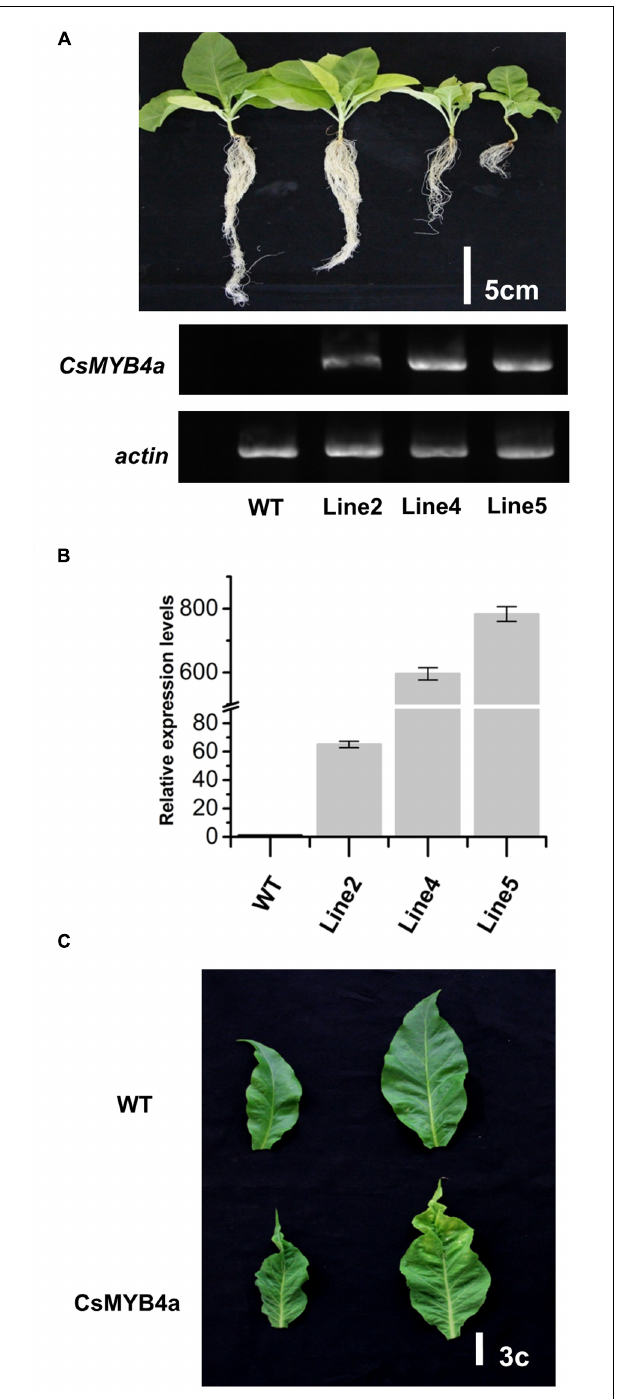
FIGURE 4 | Phenotypic comparison of CsMYB4a transgenic and wild-type N. tabacum plants. (A) Phenotypes of 50-day old T1 progenies and semi-quantitative PCR analysis of 3 different T1 generation CsMYB4a transgenic tobacco lines (line2, line4, and line5) and wild-type tobacco plants. (B) qRT-PCR analysis of the three different CsMYB4a transgenic tobacco lines (2, 4, and 5). Values represent the mean ± SD ( n = 3). (C) The leaf lesion phenotypes of T1 generation CsMYB4a transgenic tobacco (line2, line4 and line5) and wild-type